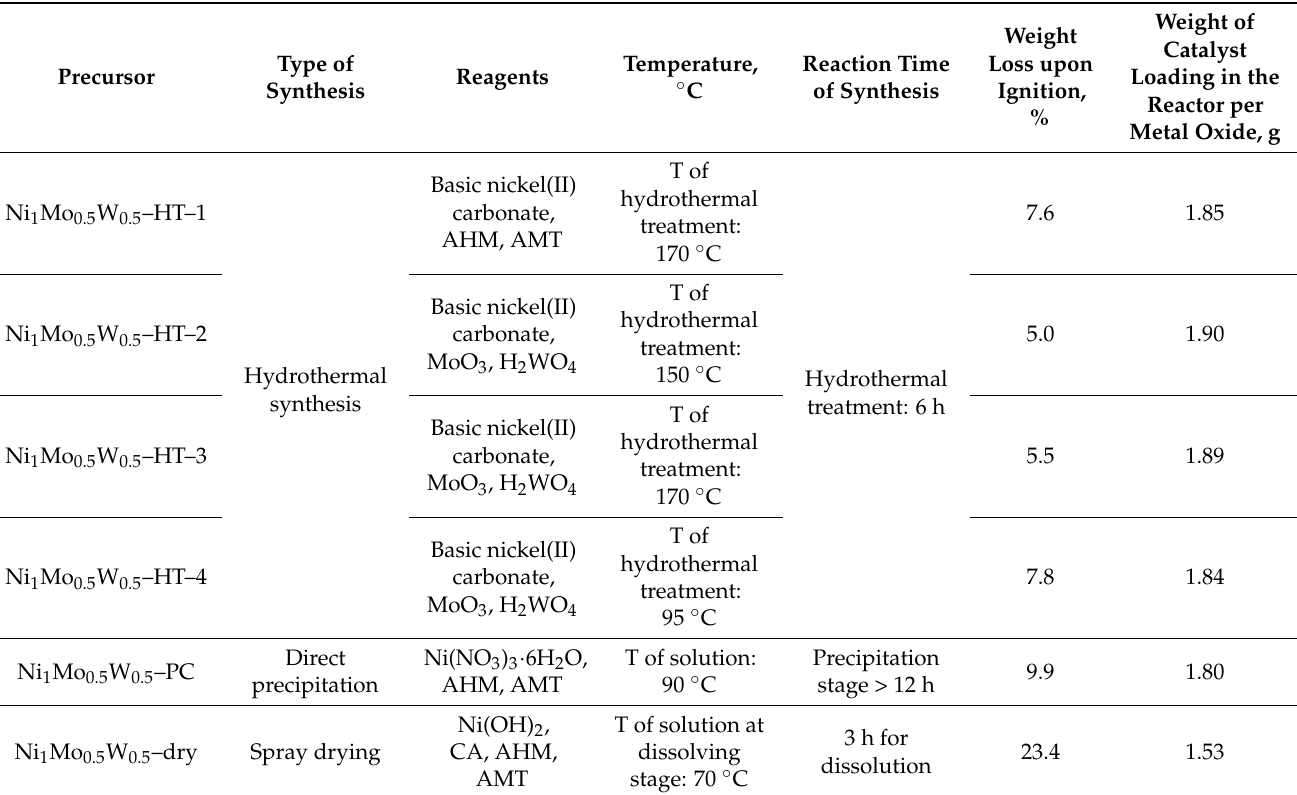
Table 1. Description of precursor